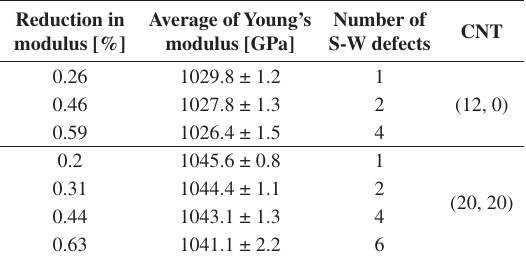
Figure 8. The Young’s modulus of defected CNTs.